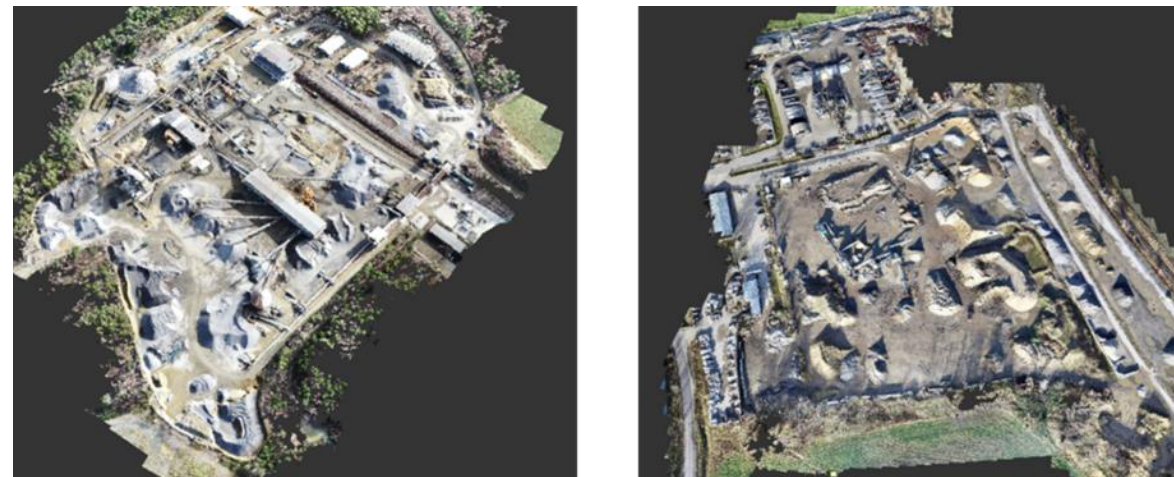
Figure 1. Point clouds of two construction material industry sites.